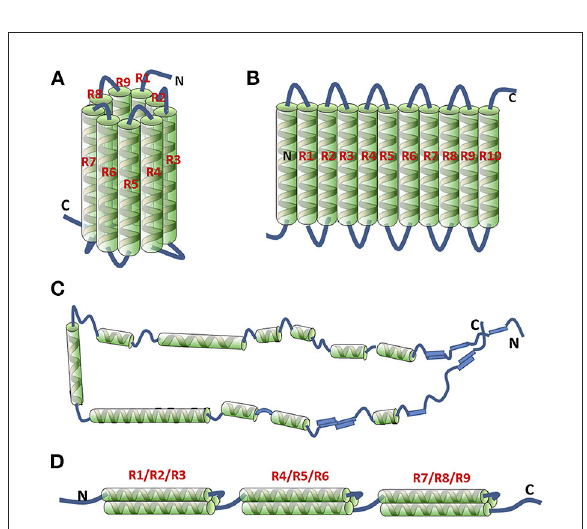
FIGURE2 Proposed 3-D structural models of α -zein. Cylindrical model (A) ; ribbon-like model (22 kDa) (B) ; hairpin model (19 kDa) (C) ; super helical structural model (19 kDa) (D) . “R” means repeat unit. Reprinted from (19) with permission from